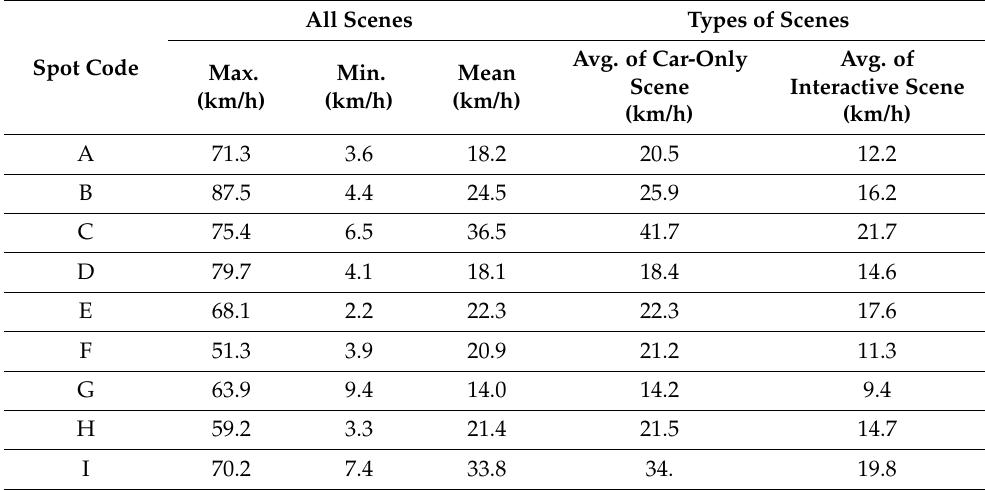
Next, we analyzed the extracted PSM distributions. Note that PSM counts how many seconds it takes for a car to pass through the same point after a pedestrian passes it, thus quantifying the potential risk of a vehicle–pedestrian collision. In our experiment, we filtered out the negative values and only looked at cars passing behind the pedestrians (negative PSM values mean that the car passed before the pedestrian). Then, we differenti- ated between the signalized crosswalks (spots A, B, C, and F) vs. unsignalized crosswalks (spots D, E, G, H, and I). Figure 14 shows the distributions of positive PSM in all signalized vs. unsignalized spots. It represents the ranges and mean values of PSM; PSMs were higher on average in signalized crosswalks than those in unsignalized crosswalks. In addition, the peak of the distribution across all signalized spots is higher, since the traffic signal forces some time to pass before cars can cross the pedestrian’s path. Without the signal, the distribution peaks are closer to zero, indicating cars are not willing to wait and give pedestrians the safety margin before passing.